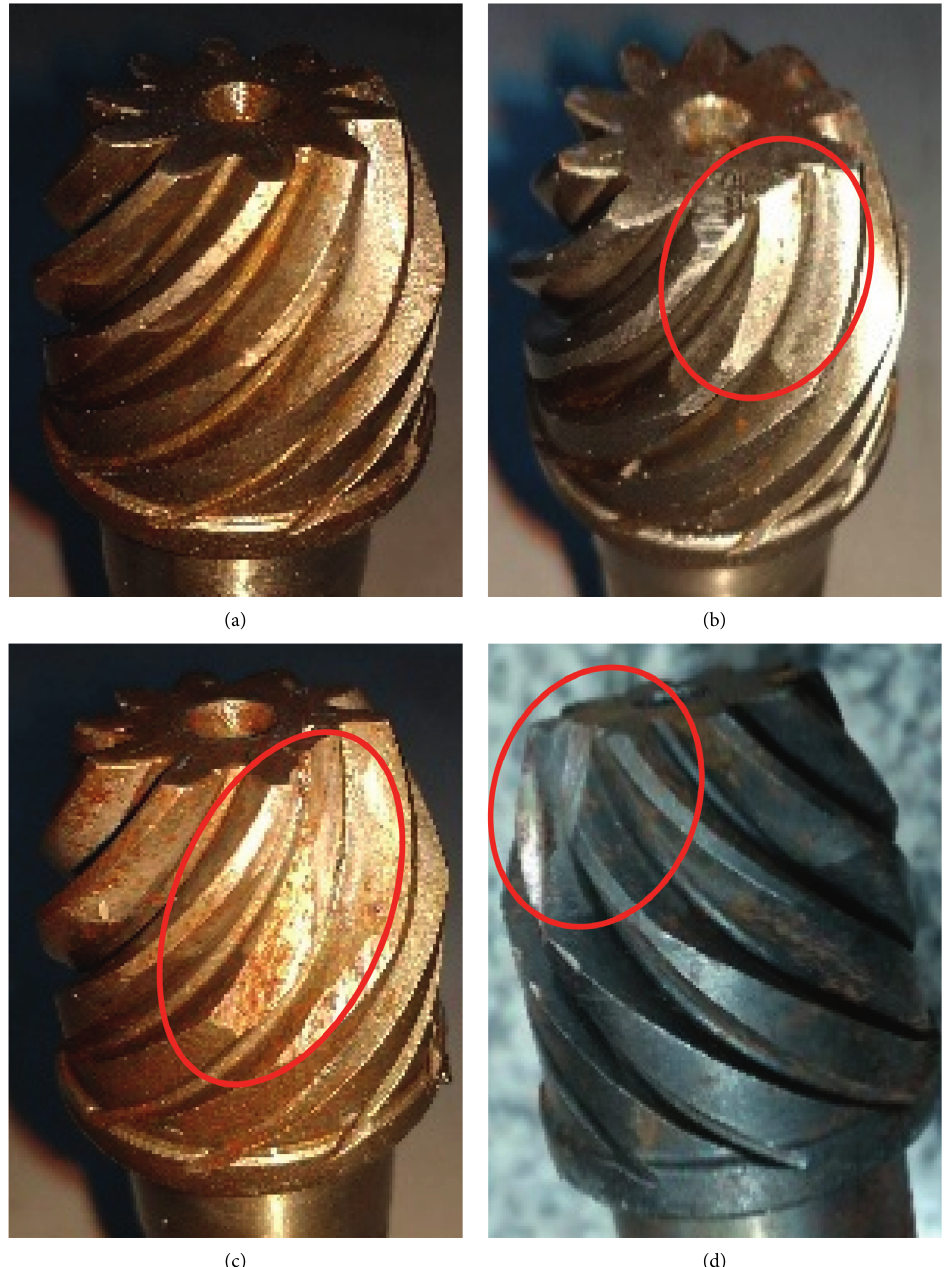
Figure 4: Gears with different fault states. (a) Normal status. (b) 1/3 broken tooth. (c) 2/3 broken tooth. (d) Severe